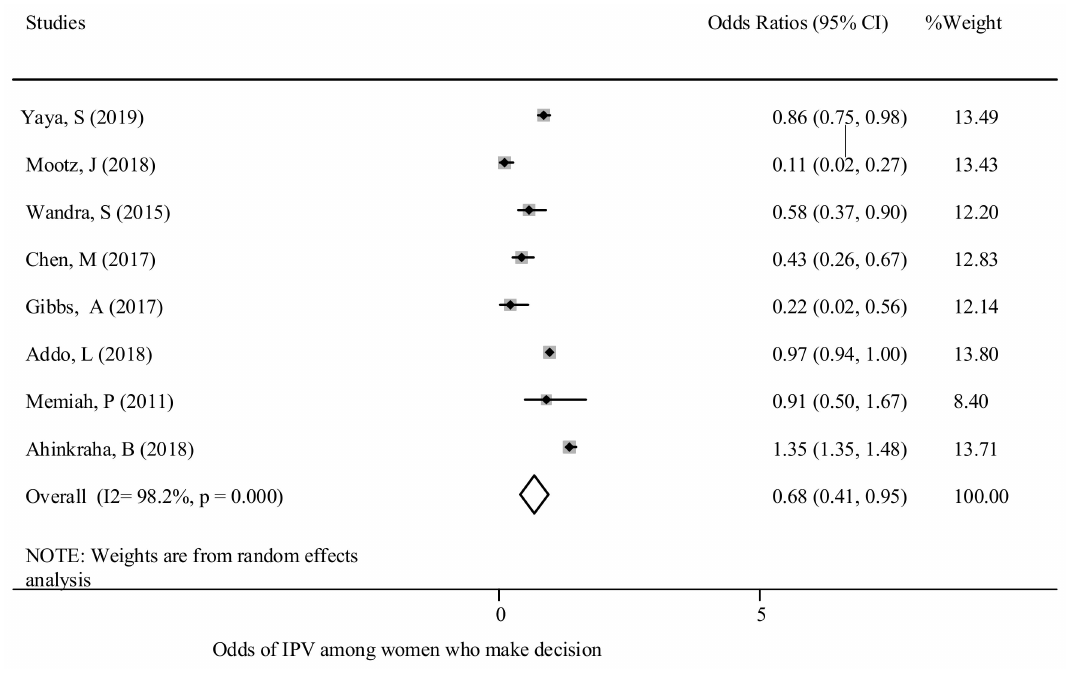
Figure 5. The association between GBV experience and decision-making power. Attitudes of women and partners - This review found that experiences of GBV were associated with attitudes of women and their partners. Women and men who are more toler- ant of GBV are more likely to consider abuse against women as being normal [17,37,47–49]. The overall pooled effect showed that women who were more tolerant towards GBV were twice as likely [OR: 2.38; 95% CI (1.26, 3.5] to experience GBV in comparison to those who were intolerant (Figure 6). Egger’s test ( p = 0.033) results are shown in Figure S6. Experiencing depression - This review found that GBV was positively associated with experiencing depression. In six studies, the findings showed that women experiencing depression or depressive symptoms were more likely to experience GBV [20,40,46,48,66]. For instance, a study conducted in SSA countries showed that women were almost two- thirds (63%) more likely to experience sexual violence if they were experiencing post- traumatic stress disorder (PTSD) [40]. A similar trend was reported in other studies [20,46]. History of child abuse - Researchers found that experiences of child abuse were positively associated with experiences of GBV against women [35,53,67]. The occurrence of GBV was found to be higher among women that had experienced physical, sexual and emotional abuse as a child [48,52,53]. Overall, experiencing child abuse was found to be a predictor of GBV in the later life span of women. Women who experienced child abuse were 2.3 times more likely to experience GBV in comparison to women who did not experience child abuse [OR: 2.33; 95% CI (1.71, 2.96)] (Figure 7). The test showed no publication bias (Egger’s test p = 0.61) (Figure